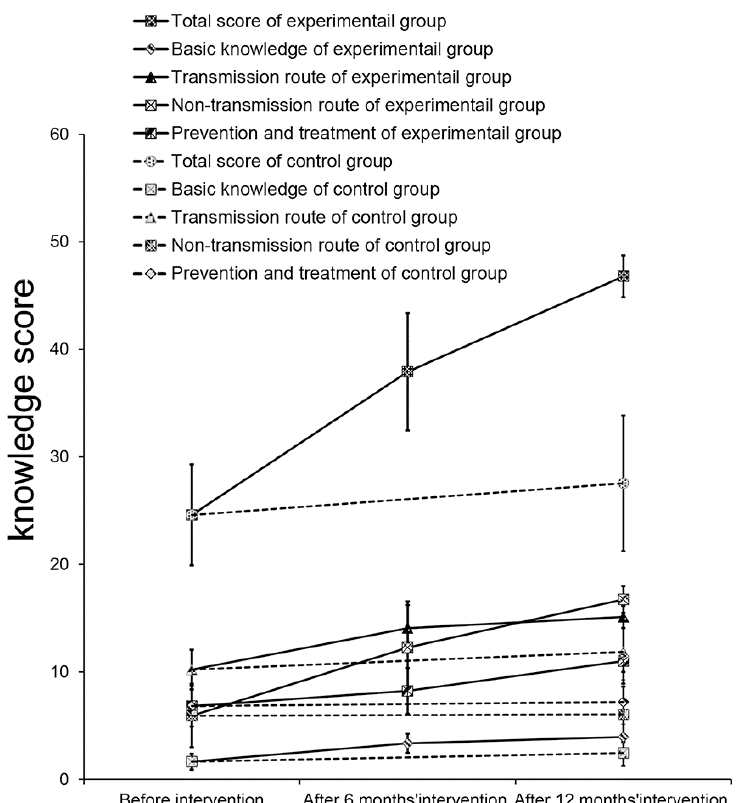
Figure 3. Changes in knowledge